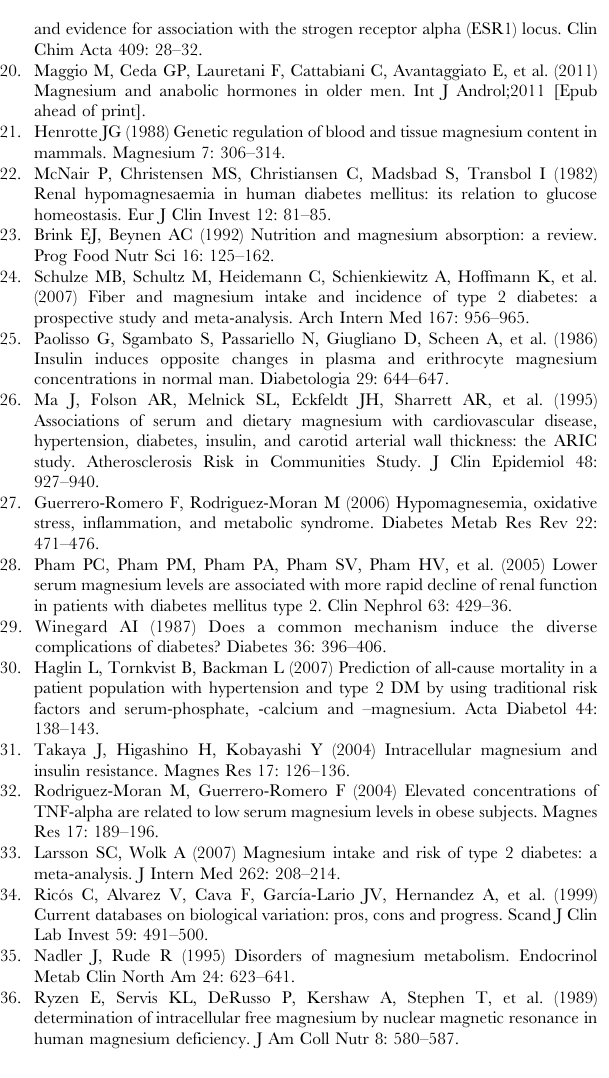
Table S1 Multiple linear regression analysis to explore variables independently related to baseline serum magnesium.